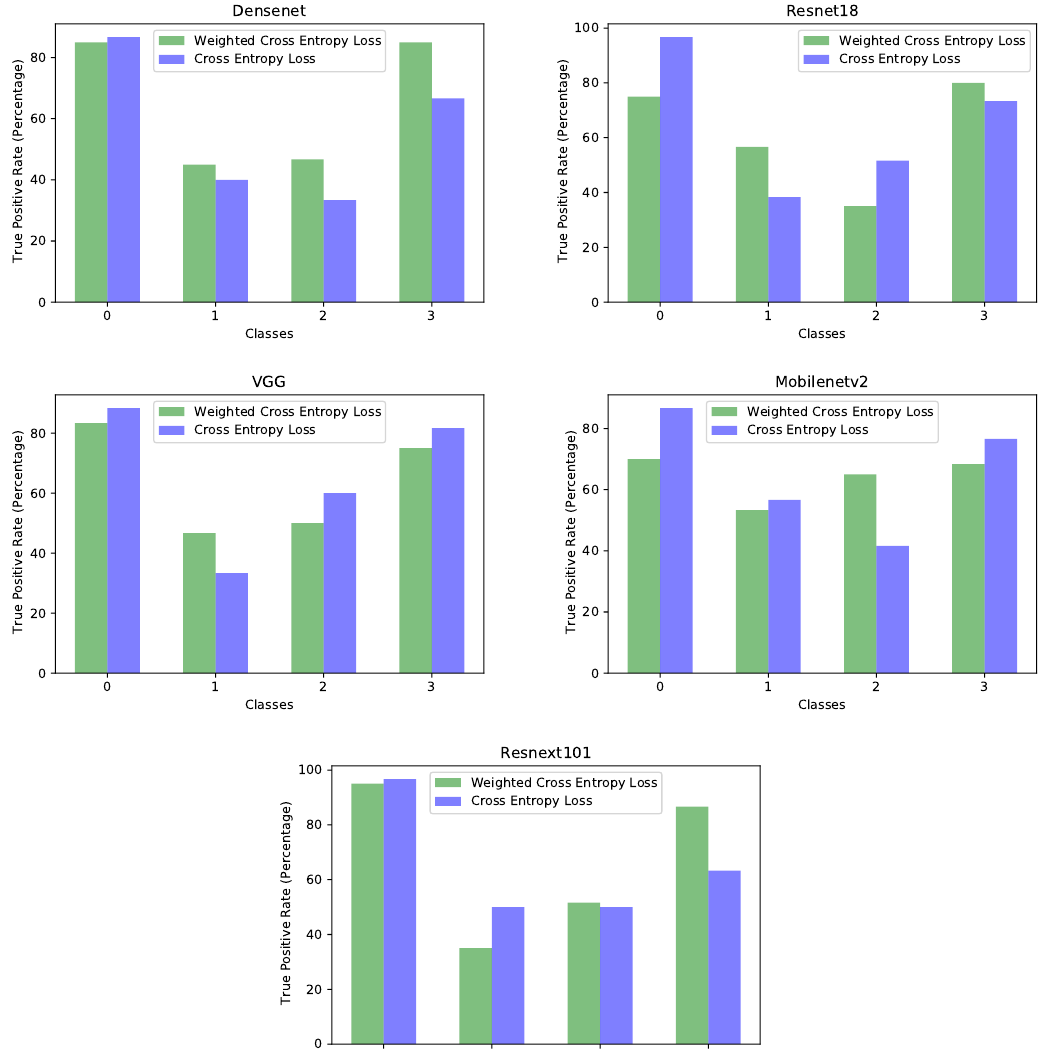
Figure 8. Per-class true positive rate comparison between models trained with cross entropy and with weighted cross entropy. Each plot displays the result for a different model. These plots are a visualization of the data from Table 9, and the same training procedures and models are